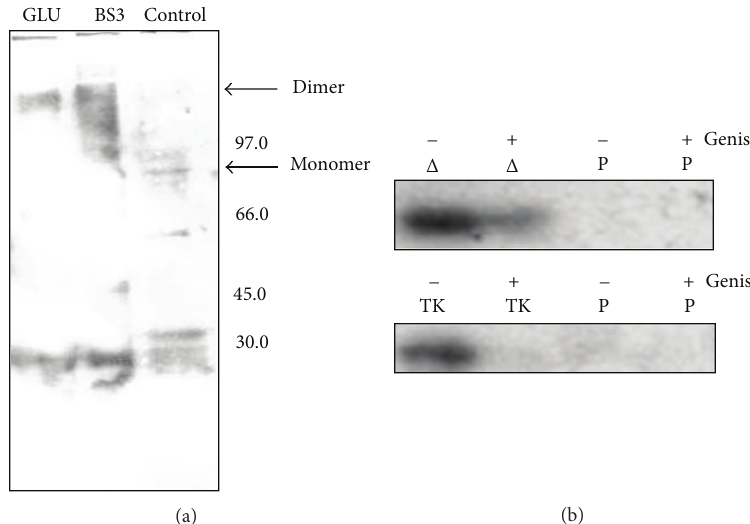
Figure 2: Dimerization and tyrosine kinase assays. Total protein extracts of E. coli transformed by pGEX-TKJM Δ ( Δ ) were treated with BS3 or glutaraldehyde (GLU) as indicated and analyzed by western blot with the anti-GST antibody (a). A control (C) without cross-linkage agent is also shown. The positions of the protein size marker (Bio-Rad) are indicated from 30 to 97 kD. The recombinant proteins were assayed with [𝛾 - 32 P ] ATP on immobilized glutathione-Sepharose beads as described in Section 2 (b). The empty pGEX-6P plasmid was used as control (P). Genistein ( Genist ) was added where